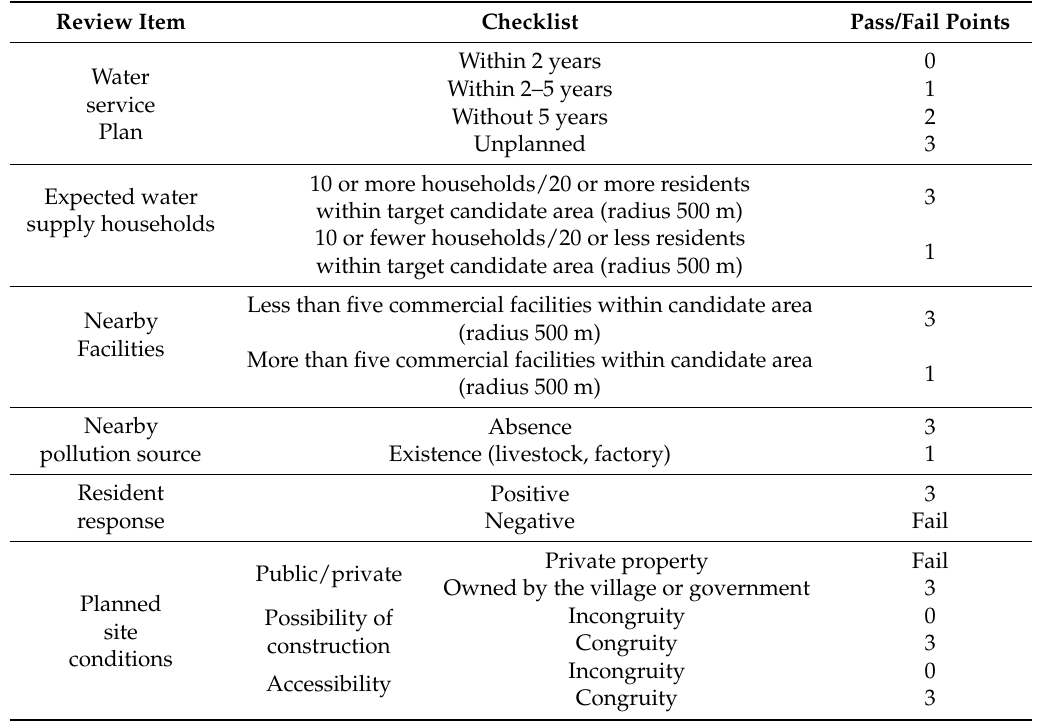
Table 5. Criteria for determining the suitability of the well installation area for drinking purpose.